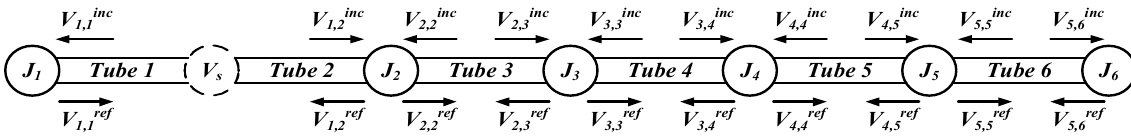
Figure 3. Signal flow diagram of an Irregular Shielded cavity irradiated by plane waves. Based on the BLT (Baum–Liu–Tesche) matrix equation of the transmission line net- work, the BLT equation to solve the node voltage response is as follows: